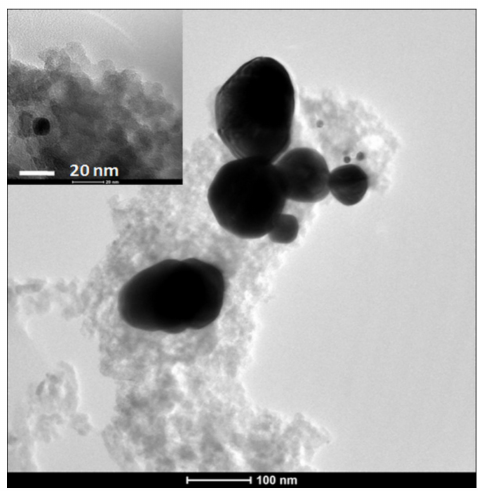
Figure 8. TEM micrographs of sample 60SiO 2 · 31.85CaO · 8P 2 O 5 · 0.15Au 2 O (mol%). (Reproduced with permission from Reference [117] published by